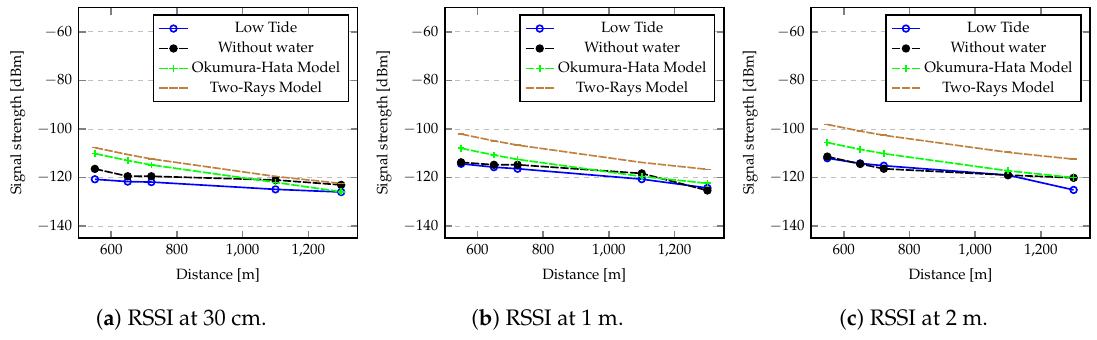
Figure 10. Comparison between experimental and theoretical RSSI values with nodes placed at 30 cm, 1 m and 2 m for ground and low tide